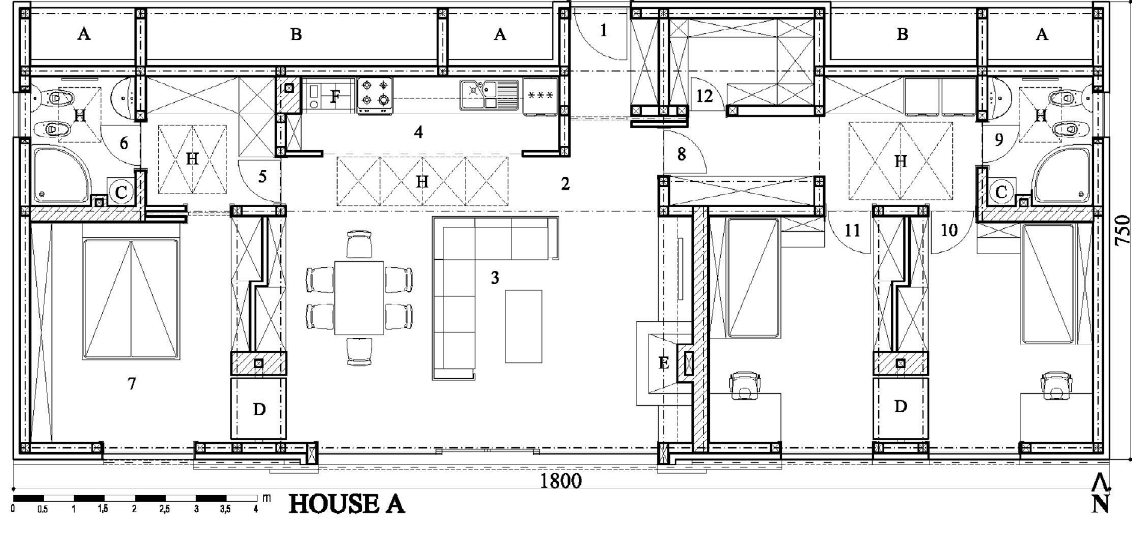
Fig. 5. Plan of House A.